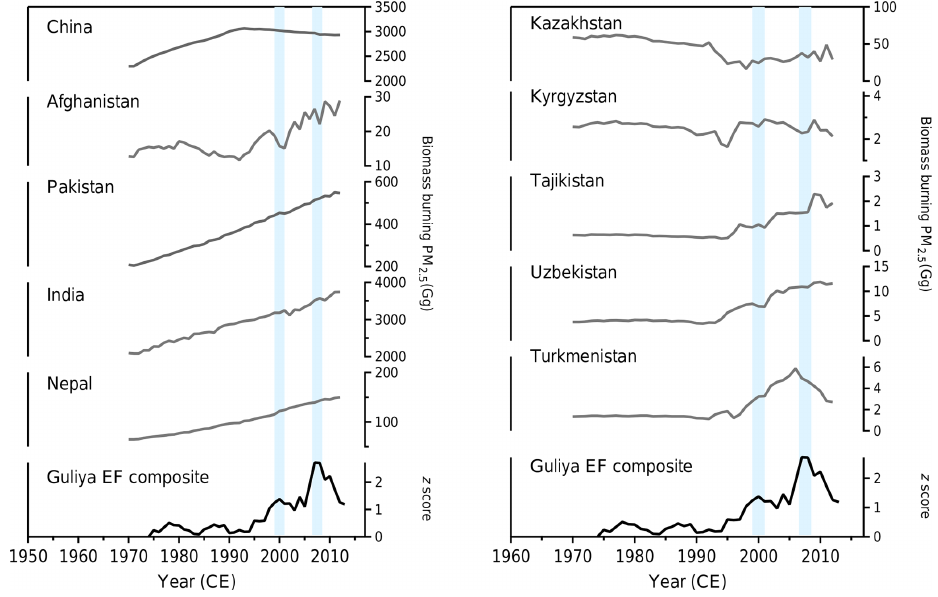
Figure 5. PM 2 . 5 emissions from biomass burning sources (EDGARv4.3.2, 2017; Crippa et al., 2018), shown in both panels for all countries. The Guliya EF composite (average of Cd, Pb, Zn, and Ni EF z scores) is shown at the bottom of each panel for comparison. The two Guliya maxima at 2000 and 2008 are shown as shaded